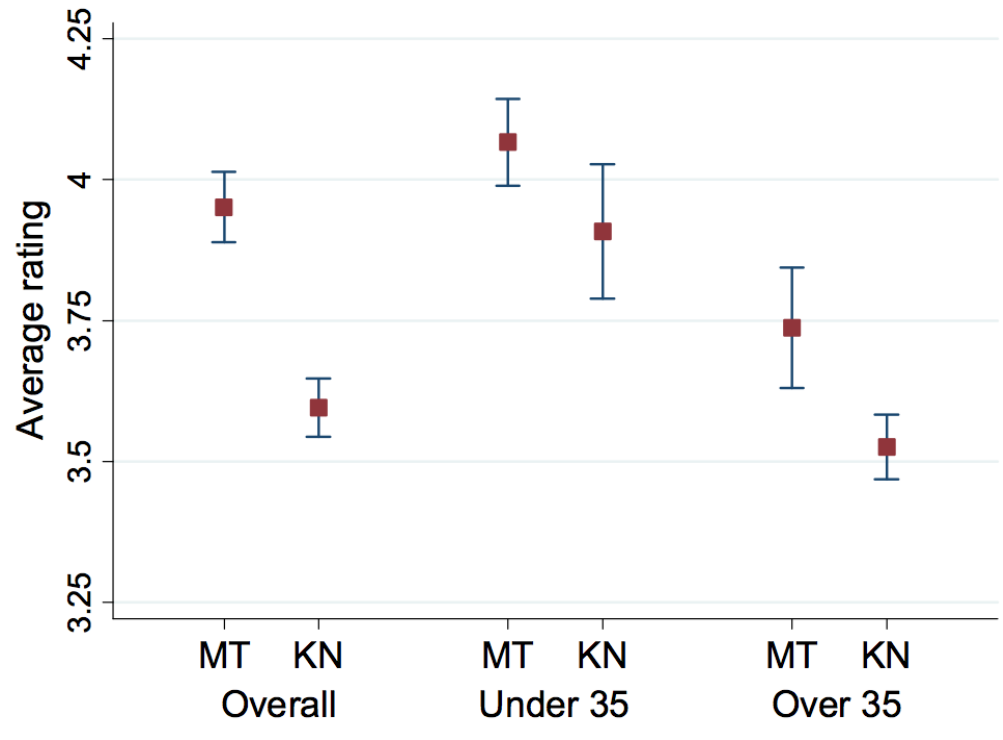
Figure 2: Differences between MT and KN respondents in responses to sexual harassment vignette, both overall and by